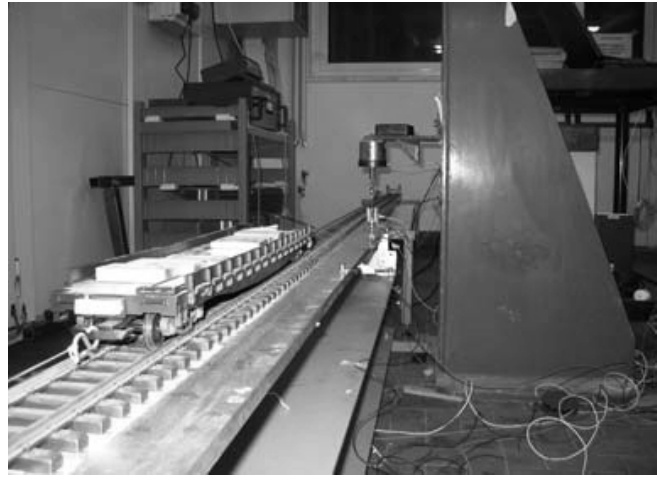
Fig. 3. The model of railway